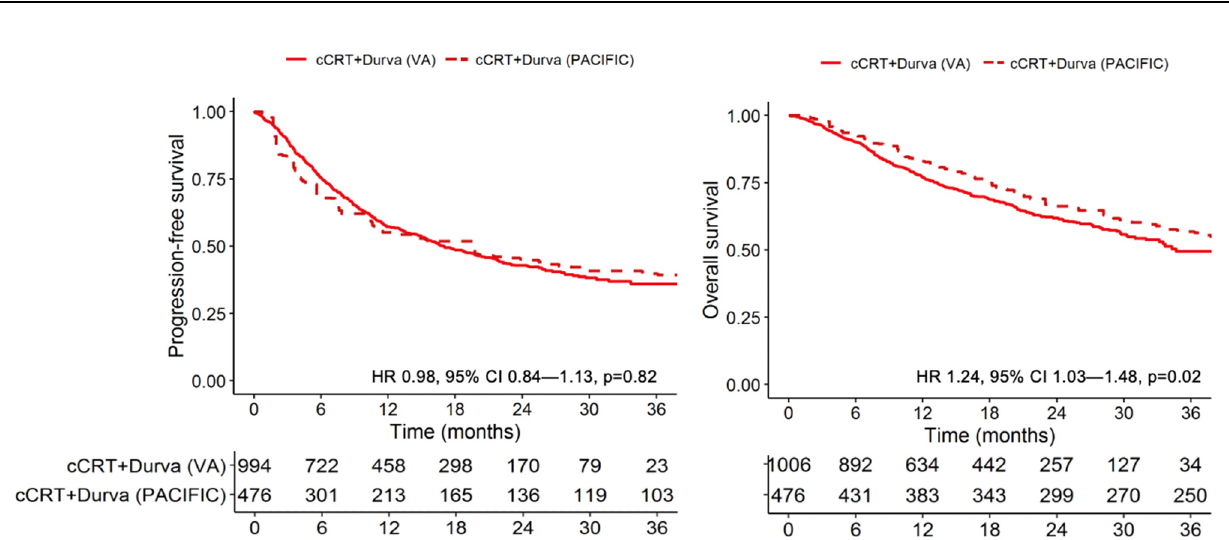
Figure 2. Kaplan–Meier progression-free and overall survival curves of real-world and clinical trial patients with stage III NSCLC who receive concurrent chemoradiotherapy and durvalumab. When investigating explanatory factors for why veterans had a shorter OS, we iden- tified that veterans in Cohort 1 received shorter duration of durvalumab therapy than patients in PACIFIC with a higher incidence of treatment discontinuation for toxicity. Among patients in Cohort 1, the median number of durvalumab infusions was 12 (IQR: 5 to 23) and the median duration of durvalumab therapy was 215 days (IQR: 84 to 350). In comparison, patients in the PACIFIC trial received a median of 20 infusions of durval- umab (range, 1 to 27) for a median duration of 310 days of treatment. The most common reasons for durvalumab discontinuation in Cohort 1 were completion of planned therapy ( n = 314, 31.2%), disease progression ( n = 221, 21.9%), irAE ( n = 152, 15.1%), and non-irAE toxicity attributed to durvalumab (n = 60, 5.9%). Among the 152 patients who discontin- ued durvalumab due to irAE, the most common grade 3 or higher irAE event was pneu- monitis ( n = 109, 10.8%). A total of 136 patients (13.5%) had ongoing durvalumab therapy at the time of last follow-up. In the PACIFIC cohort, among 713 patients, reasons for dur- valumab termination included completion of therapy ( n = 202, 28.3%), disease progression (n = 148, 20.8%), and adverse event leading to treatment discontinuation ( n = 73, 10.2%). The incidence of grade 3 or 4 pneumonitis in PACIFIC was 3.4%. 4. Discussion We report the largest series of patients with stage III NSCLC treated with cCRT and adjuvant durvalumab in a cohort of over 1000 veterans who received their care at a VHA medical center. We show that durvalumab consolidation in veterans is associated with a large PFS and OS benefit relative to contemporary historical controls, though OS in the veteran population is still inferior to durvalumab-treated patients in PACIFIC, with an EE gap of 0.73. To our knowledge, this is the first study that directly compares real-world and clinical trial cohorts within a population of patients with stage III NSCLC who were not included in the PACIFIC trial. An observational cohort multicenter international study to evaluate real-world efficacy of cCRT and adjuvant durvalumab in patients with stage III NSCLC is ongoing but data have not yet been reported (PACIFIC-R, NCT03798535). Fur- thermore, the veteran population is diverse, including patients with co-morbidities, older age, and those living in rural areas, who are likely to be excluded from many clinical trials. Thus, these data represent a unique means for assessing real-world outcomes for this im- portant new therapy. The results demonstrate that the use of durvalumab consolidation among veterans after cCRT is associated with a significant improvement in both OS and PFS compared to